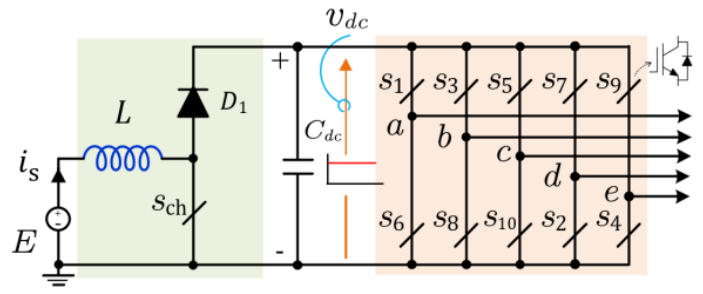
Figure 18. Evaluation of AC output current ripple using the time-domain analysis.